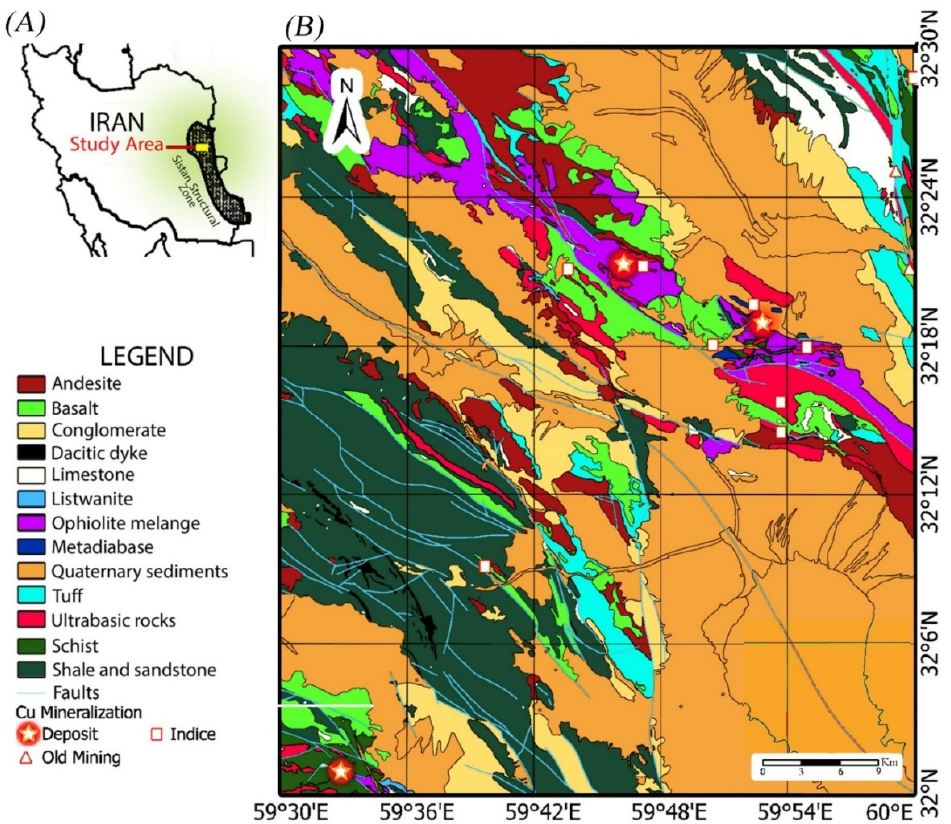
Figure 1. ( A ) Geographical location of Sistan Structural Zone (SSZ) and the study area in Iran. ( B ) Detailed geology map of the Sahlabad mining Area (modified from [23]).